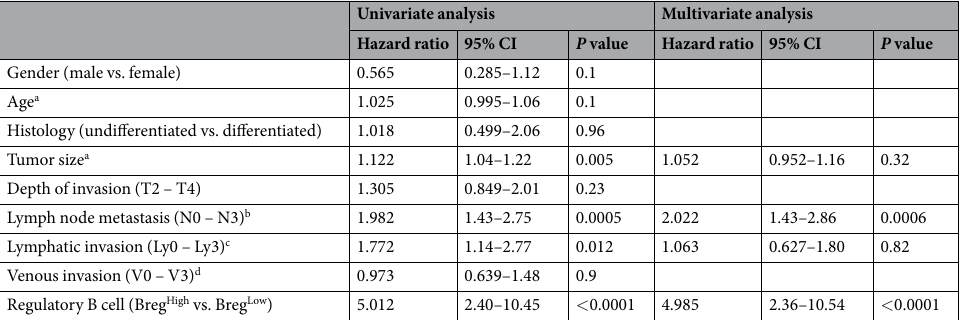
Table 3. Univariate and multivariate analysis of factors prognostic for overall survival in patients with GC. a Continuous variables b N0: no regional lymph node metastases; N1: Metastasis in 1–2 regional lymph nodes; N2: Metastasis in 3–6 regional lymph nodes; N3; Metastasis in ≥ 7 regional lymph nodes. c Lymphatic invasion: Ly0–Ly3, grade of lymphatic invasion. d Venous invasion: V0–V3, grade of venous invasion. See Table 1 for details of histology and depth of invasion. CI: confidence